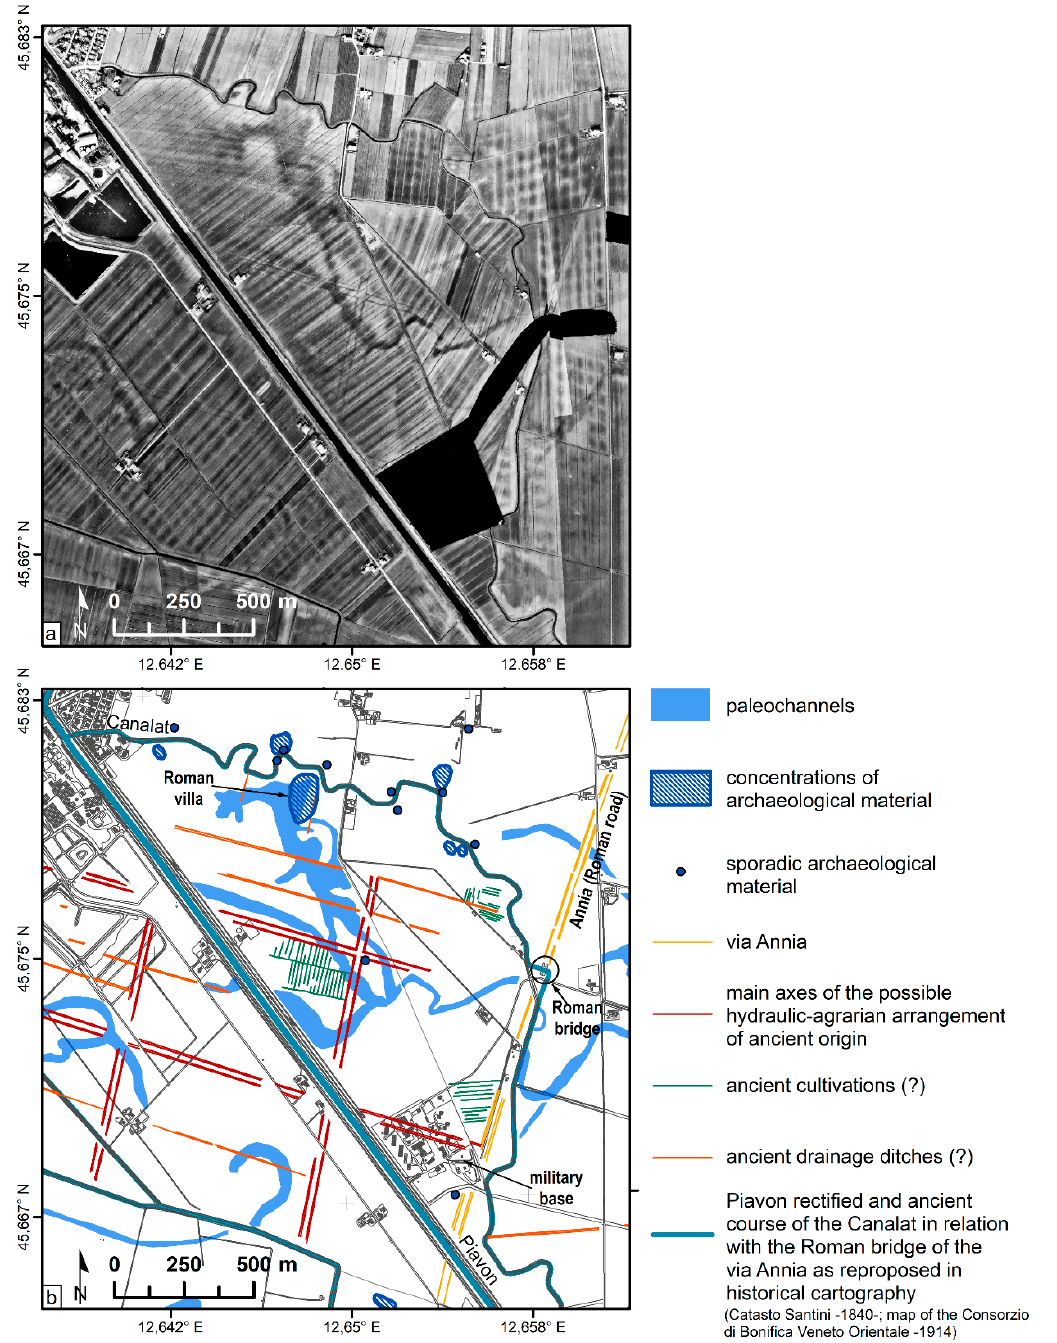
Figure 4. SE area of Ceggia. ( a ) System of traces visible in ReVen 1983 aerial frames. ( b ) Photorestitution on CTR 1:5000 of the signs detected through multitemporal analysis of historical aerial images (IGM 1937, GAI 1954, ReVen 1983 and Reven 1990) and new archaeological data deduced through surveys (2014–2017).